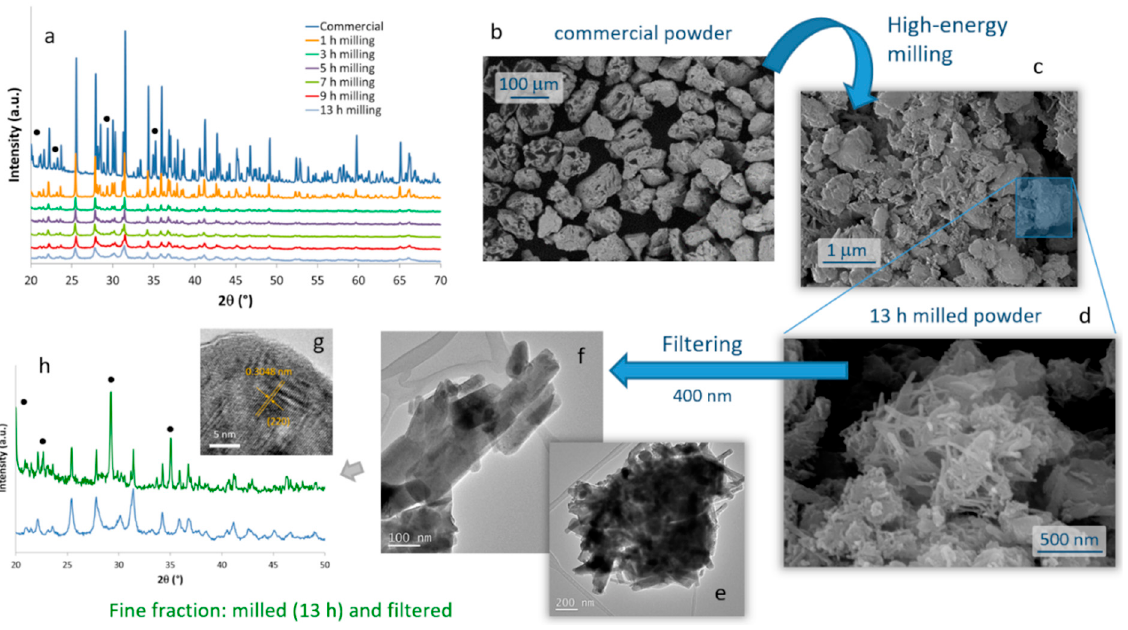
Figure 1. Processing steps to obtain the SrAlO:Eu,Dy nanoparticles. ( a ) Evolution of the high-energy milling process of the commercial powder as followed by XRD. Black circles indicate the maxima of the SrAl 2 O 4 phase, minority at this point, all other peaks correspond to the Sr 4 Al 14 O 25 phase. ( b –d) SEM images at different times of the mechanosynthesis stage and ( e – g ) nanoparticles obtained after filtration of the milled powder for 13 h. ( h ) XRD of the 13 h milled (blue pattern)and filtered (green) powder indicating that the major phase is now SrAl 2 O 4 (black circles).